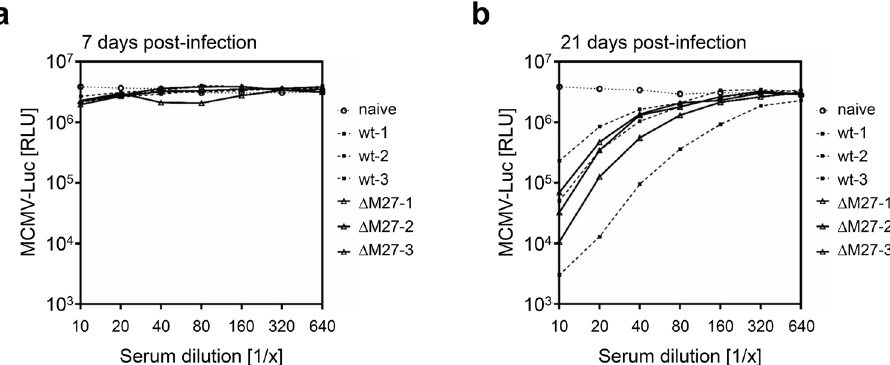
Fig. 5 Immunization with Δ M27-MCMV elicits neutralizing antibody responses. BALB/c mice were infected i.p. with wt-MCMV or Δ M27- MCMV. At 7 and 21 dpi, serum samples were collected. Different dilutions of serum samples were incubated with MCMV:Luc for 90 min prior to infection of fi broblasts. At 24 h post-infection, cells were lysed and luciferase activity was measured. a Neutralizing capacity of serum samples collected at 7 dpi. b Neutralizing capacity of serum samples collected at 21